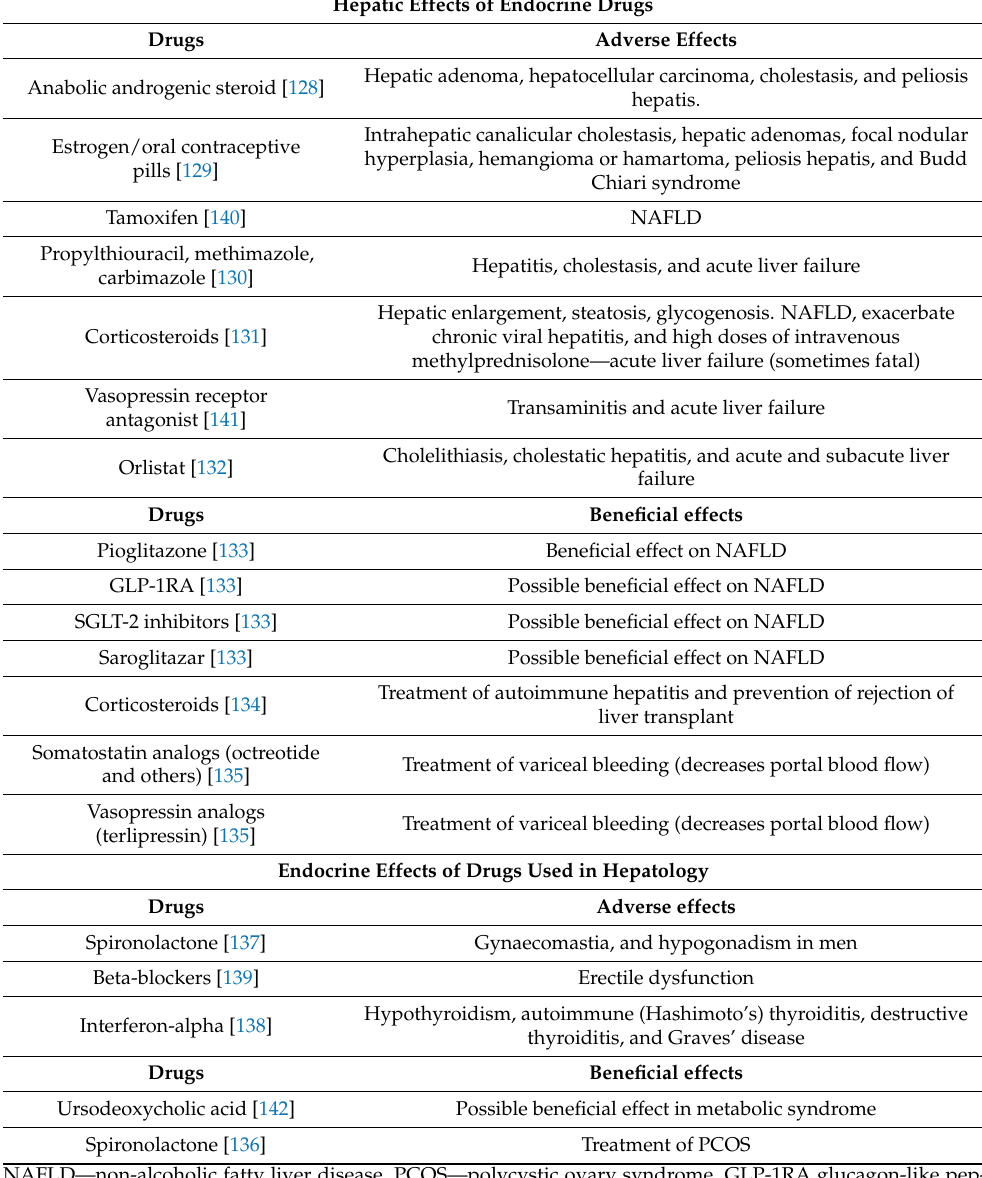
Table 5. Pharmacological interactions in